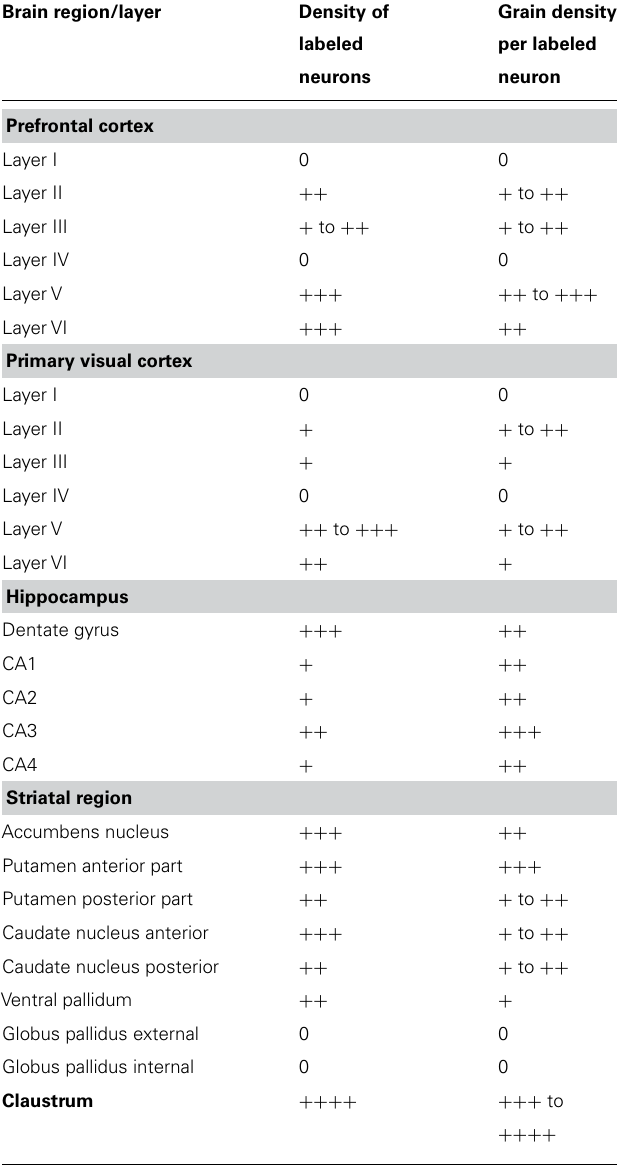
Table 1 | κ -opiod receptor densities in the human brain. Brain region/layer Density of